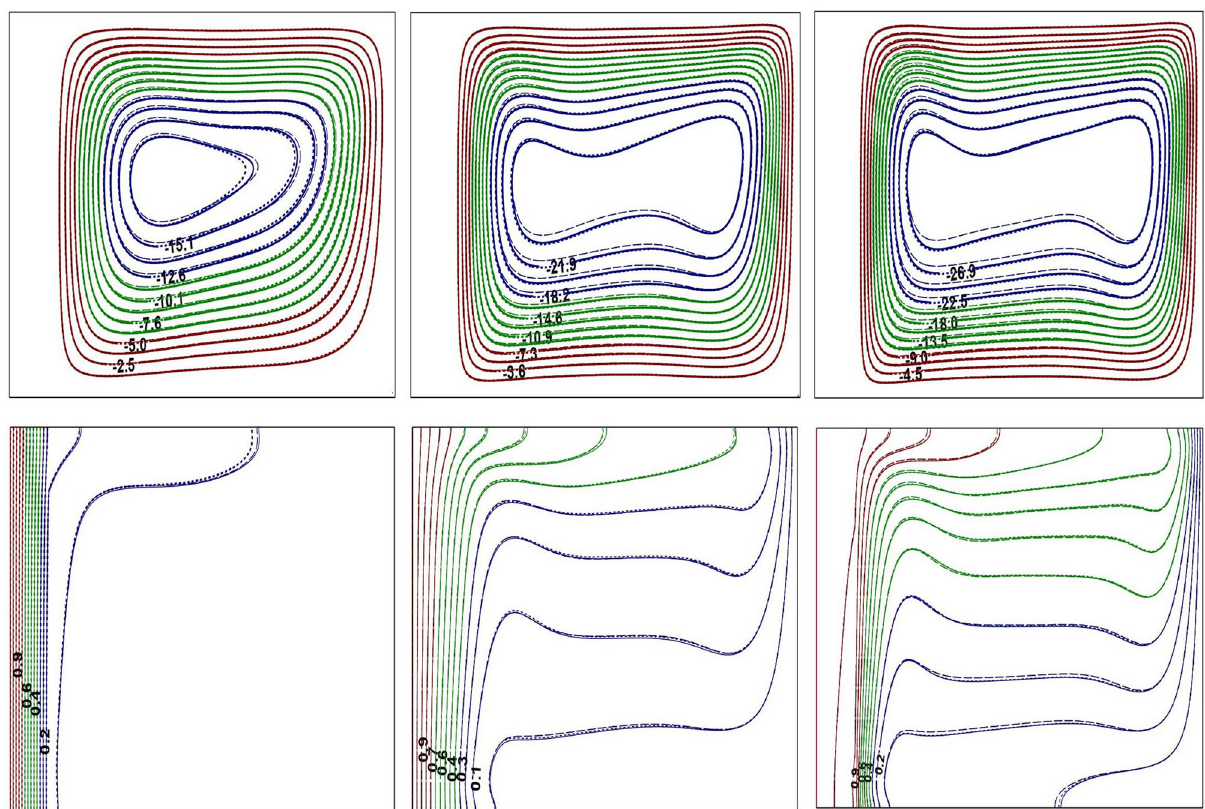
6 , φ = 0.1 and ε = 0.1 . Kr = 0.1 (left),